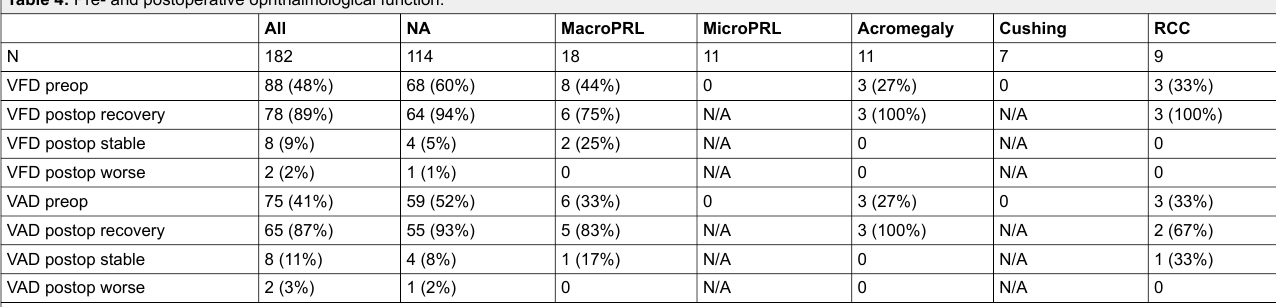
Table 4: Pre- and postoperative ophthalmological function.